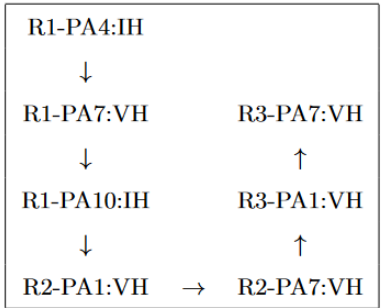
Figure 6. The order of the detected